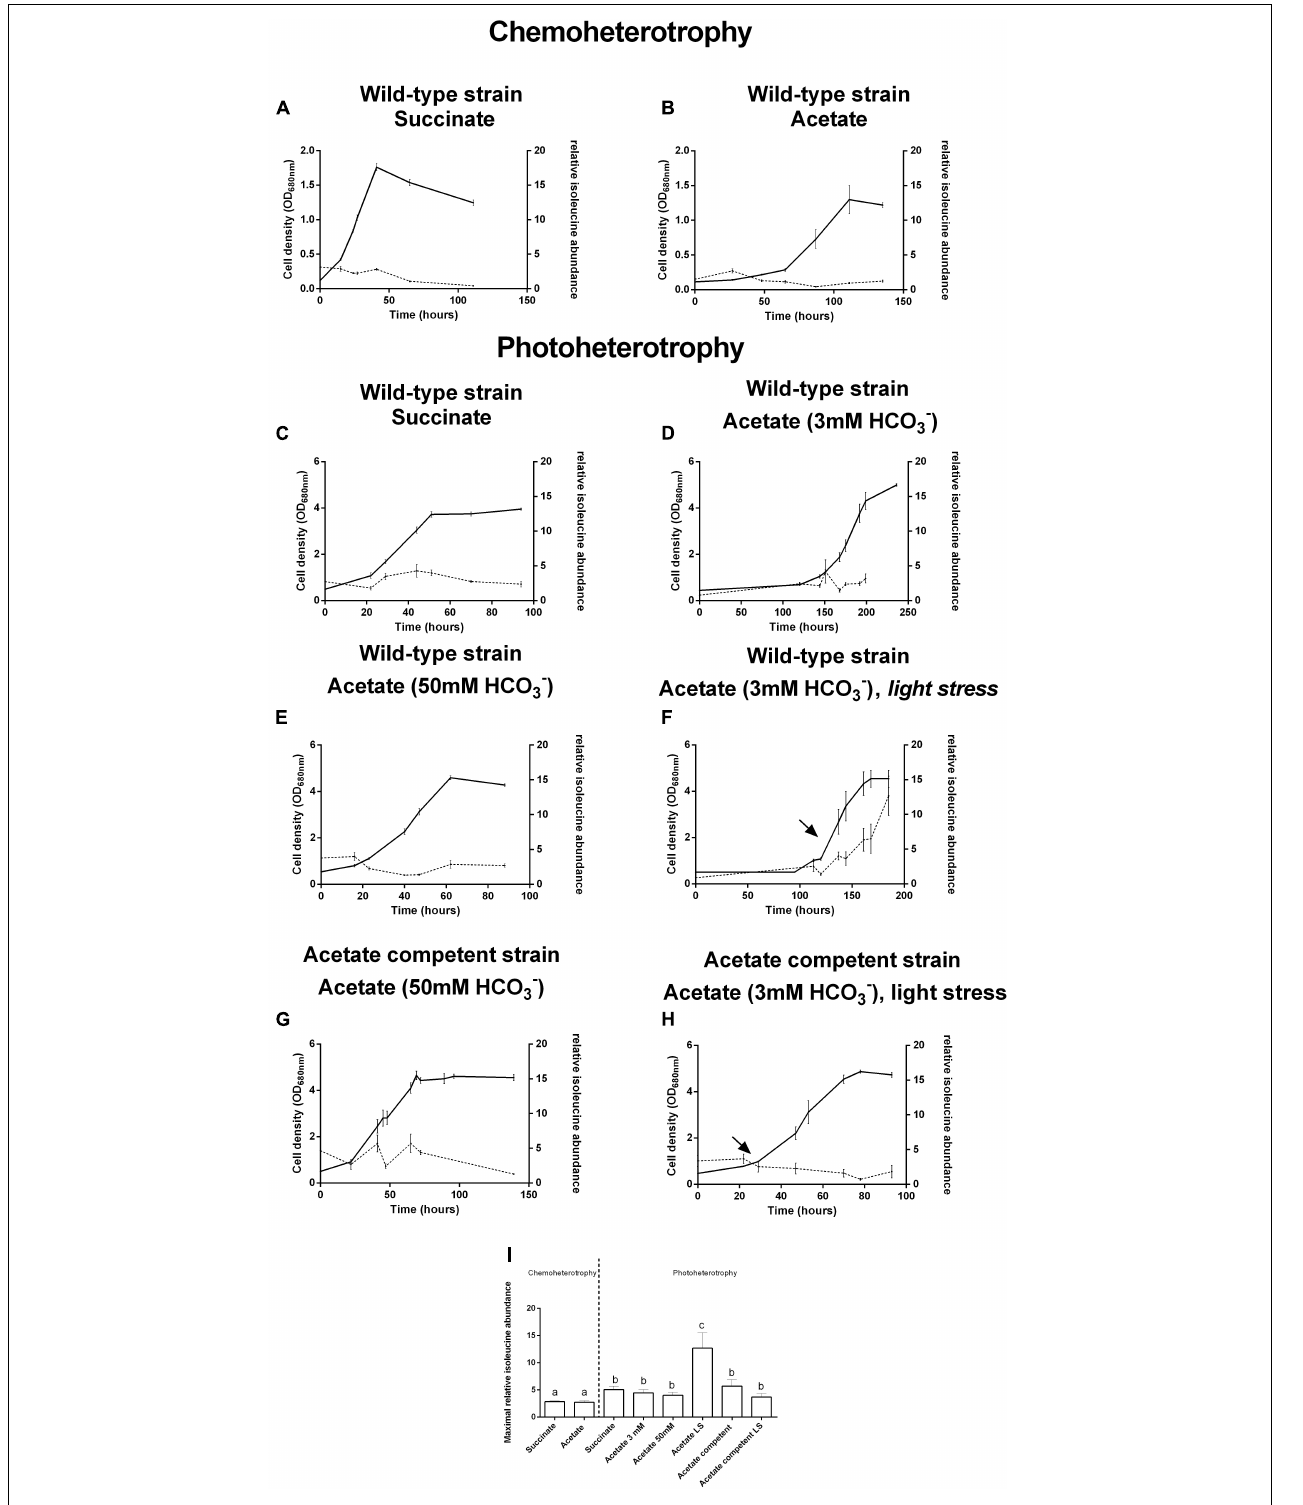
FIGURE 1 | Growth ( full lines ) and relative isoleucine abundance ( dotted lines ) of Rhodospirillum rubrum wild-type (A–F) and acetate competent (G,H) strains in the presence of succinate (A,C) or acetate (B,D–H) under the chemoheterotrophic (A,B) or the photoheterotrophic (C–H) regime. Arrows represent light stress. Relative isoleucine abundance is expressed as the ratio between the area under the curve obtained in multiple reaction monitoring (MRM) of the isoleucine trace and the area under the curve of arginine. Maximal relative isoleucine abundances are aggregated in (I) . N = 5. Results are represented as the mean ± SEM. Lowercase letters in (I) represent statistical groups ( t -test: p <